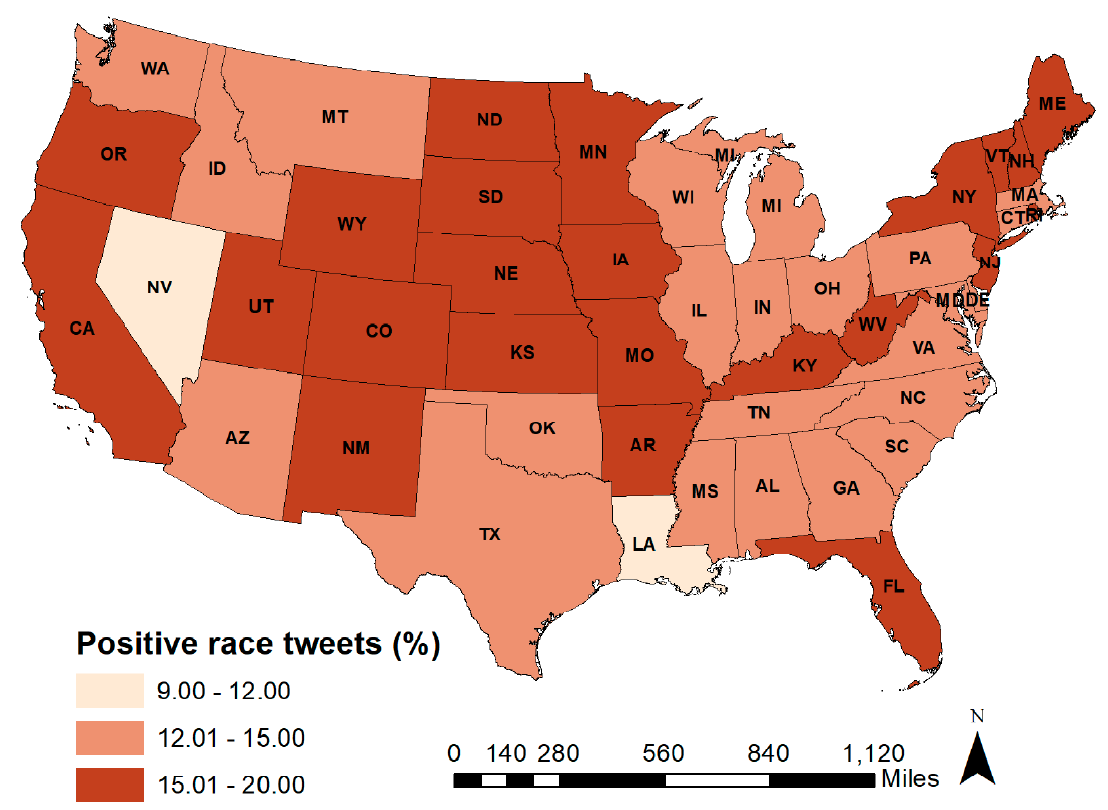
Figure 1. Geographic distribution of percent tweets using race ‐ related terms that are positive, collected April 2015–March 2016. Table 1. Twitter ‐ derived sentiment by month of year, 2015–2016.